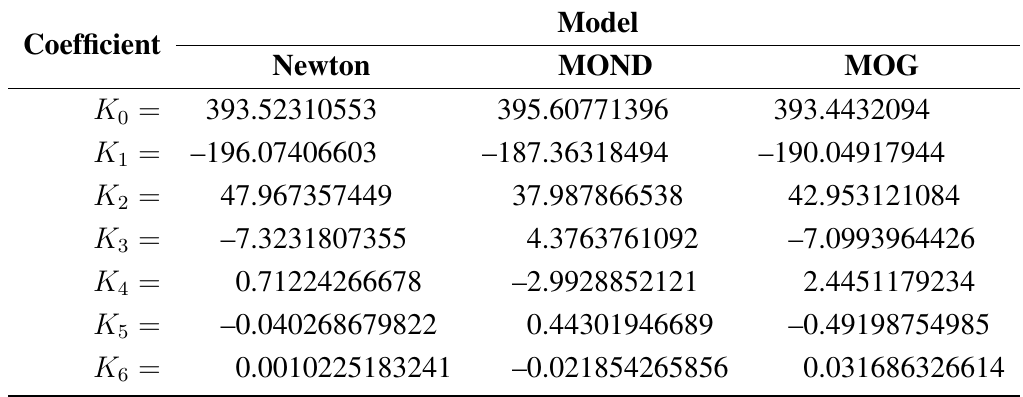
Table A1. Polynomial coefficients used to approximate Equation (6).